Question: Write a caption explaining this figure to a reader.
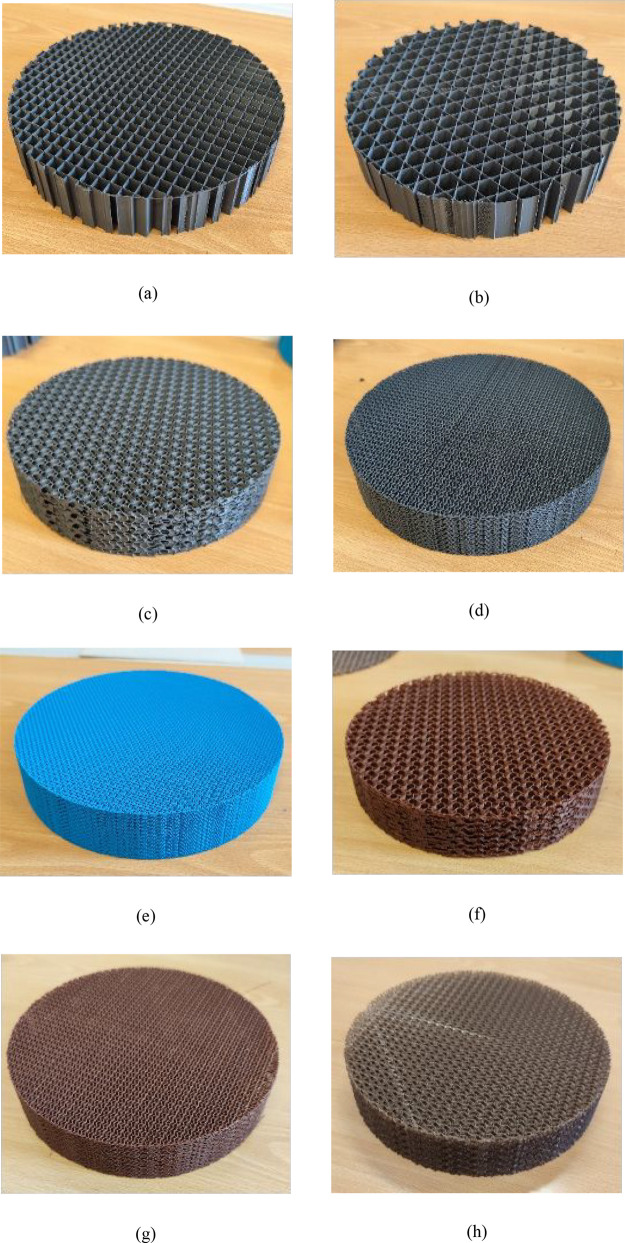
Answer: Images of the 3D-printed specimens: (a) PLA_Grid10%, (b) PLA_Trihexagonal10%, (c) PLA_Gyroid10%, (d) PLA_Gyroid20%, (e) PLA_Gyroid30%, (f) Cork_Gyroid10%, (g) Cork_Gyroid20%, and (h) Coffee_Gyroid10%.